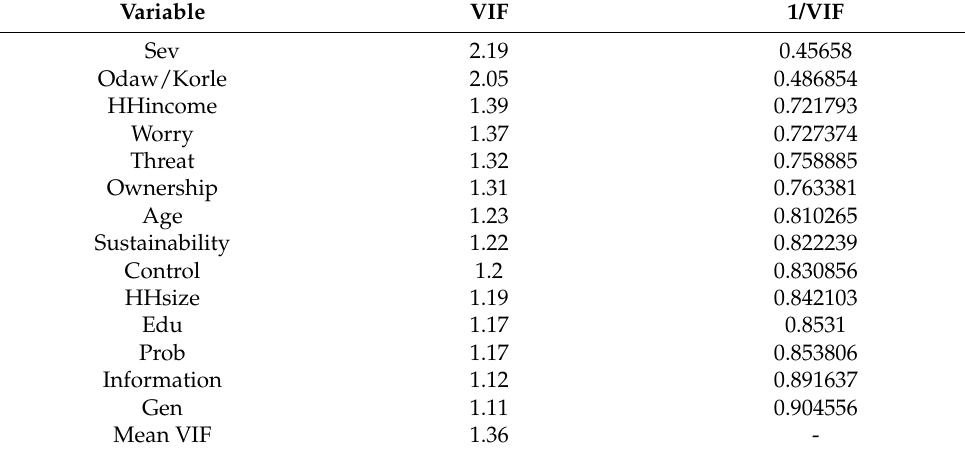
Table 5. Variance inflation